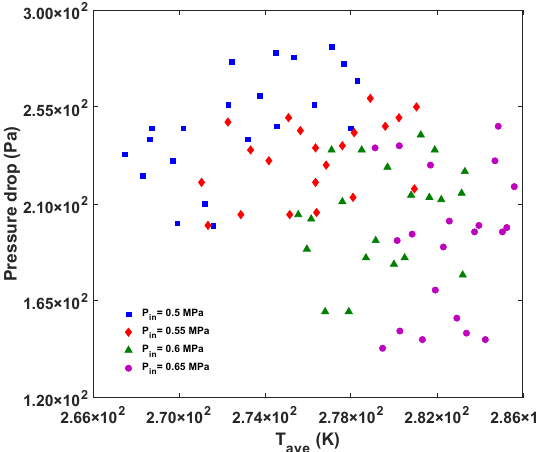
Figure 6. Pressure drop of the R22 versus the average temperature under di ff erent pressures for − 2 G = 10.52 kg m s − 1